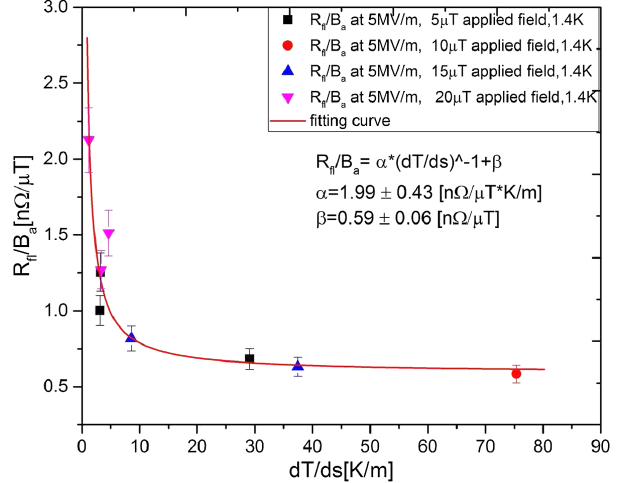
FIG. 5. The R normalized by an applied field B a as a function fl of dT=ds . The red solid curve represents the fitting curve given by Eq.